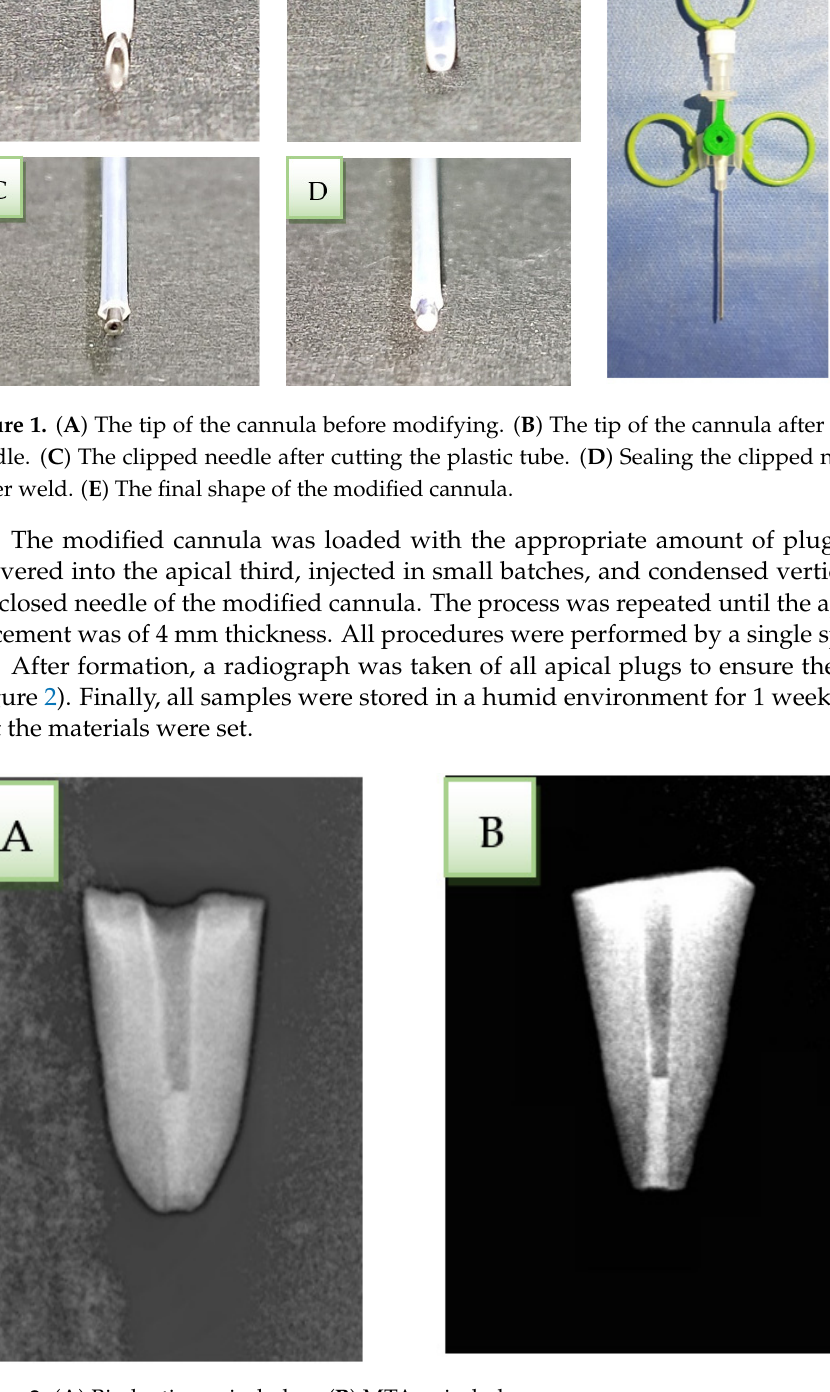
Figure 2. ( A ) Biodentine apical plug. ( B ) MTA apical plug. A digital timer (Simex, Persiceto, BO, Italy) was used to calculate the time needed to load, place and condense both materials.